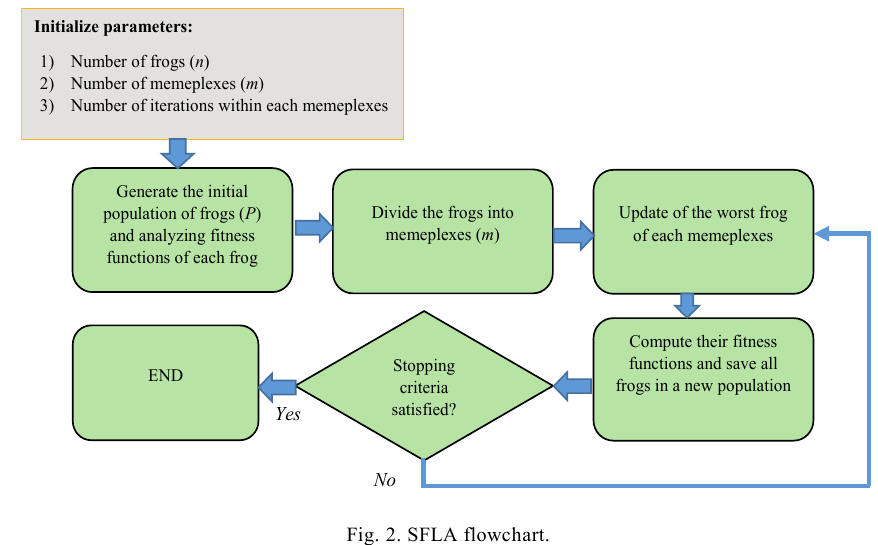
Fig. 2. SFLA flowchart.